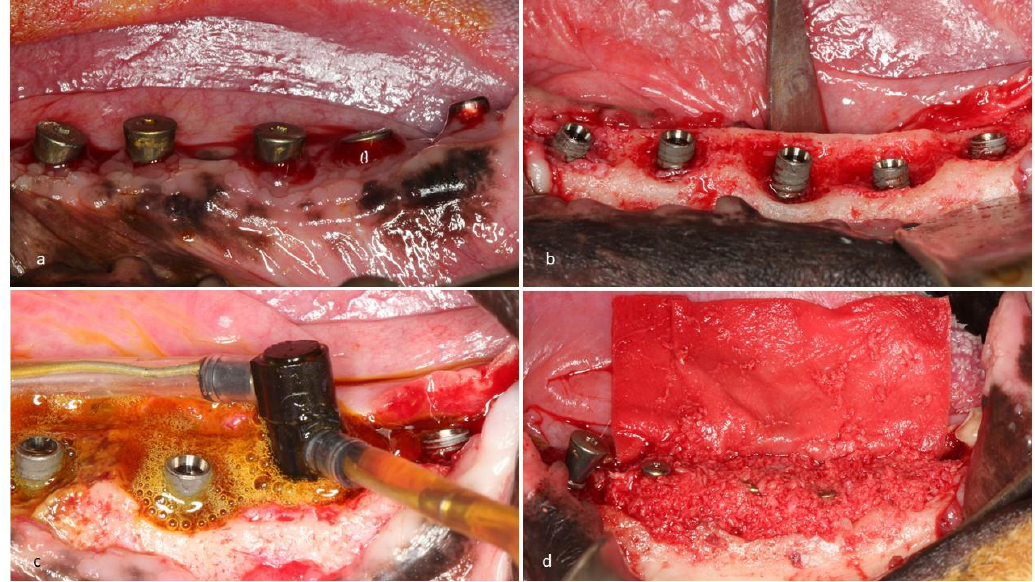
Figure 4. ( a ) Infected site prior to treatment, ( b ) reflected flap indicates a complex merged defect morphology, ( c ) electrolytic cleaning with a spray-head, ( d ) augmented site before collagen membrane was applied.